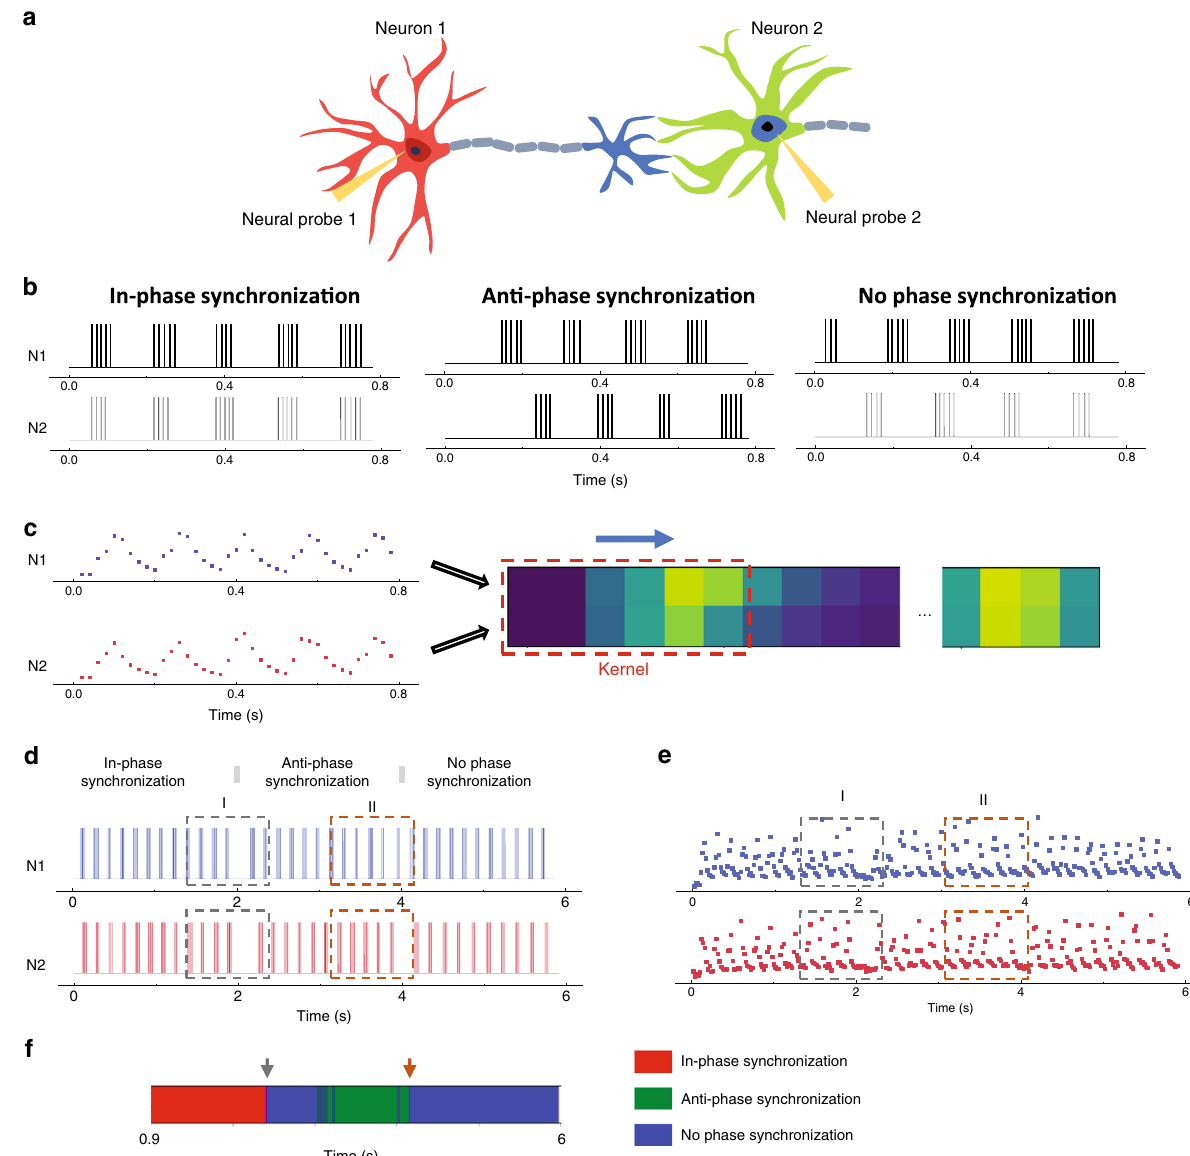
Fig. 5 Real-time analysis of neural synchronization. a Schematic showing two interacting neurons, each recorded by a neural probe. b Typical spike trains that form in-phase synchronization (left), anti-phase synchronization (middle), and no phase synchronization (right) for two neurons N1 and N2. c Schematic of the RC setup. The reservoir states from two memristors form a two-row matrix that are applied to the readout layer. A 6 × 2 kernel convolutes the inputs with a stride of two to produce a 20 × 1 feature map, which is then processed by the 20 × 3 perceptron (not shown) in the readout layer to produce the fi nal output. d and e Spike trains showing synchronization states evolving from in-phase synchronization, anti-phase synchronization to no phase synchronization d , and experimentally measured device states in two memristors e . The gray bars in d mark the transition between different synchronization states. f Classi fi cation results from the RC system. The arrows indicate the moments when the synchronization state transitions are